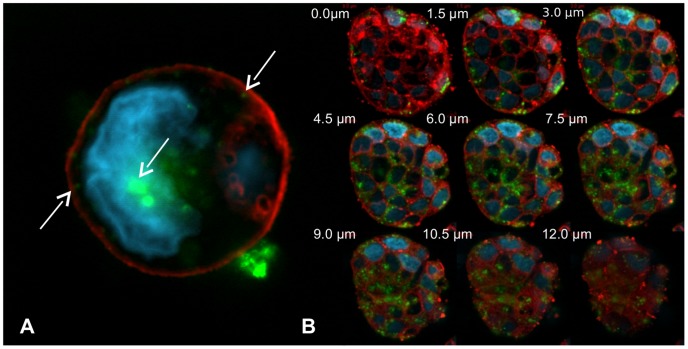
Confocal images of undifferentiated Caco-2 cells.Cells were treated with the solution of 0.05-RAMEB and 5 mM RAMEB (FRR). FITC-RAMEB (green) is localized in small vesicles (white arrows) under the CellMask labeled cell membrane (red) or in larger vesicles near the DAPI stained cell nucleus (light blue). Aggregated particles of FITC-RAMEB can be also seen outside the cell membrane (A). Nine consecutive confocal sections of a cluster of cells were recorded (B). Each section is one and half micrometer thick. FITC-RAMEB (green) is located in cytoplasmic granules. The granular bright particles are observed inside the cell membrane and outside of the cell nuclei.